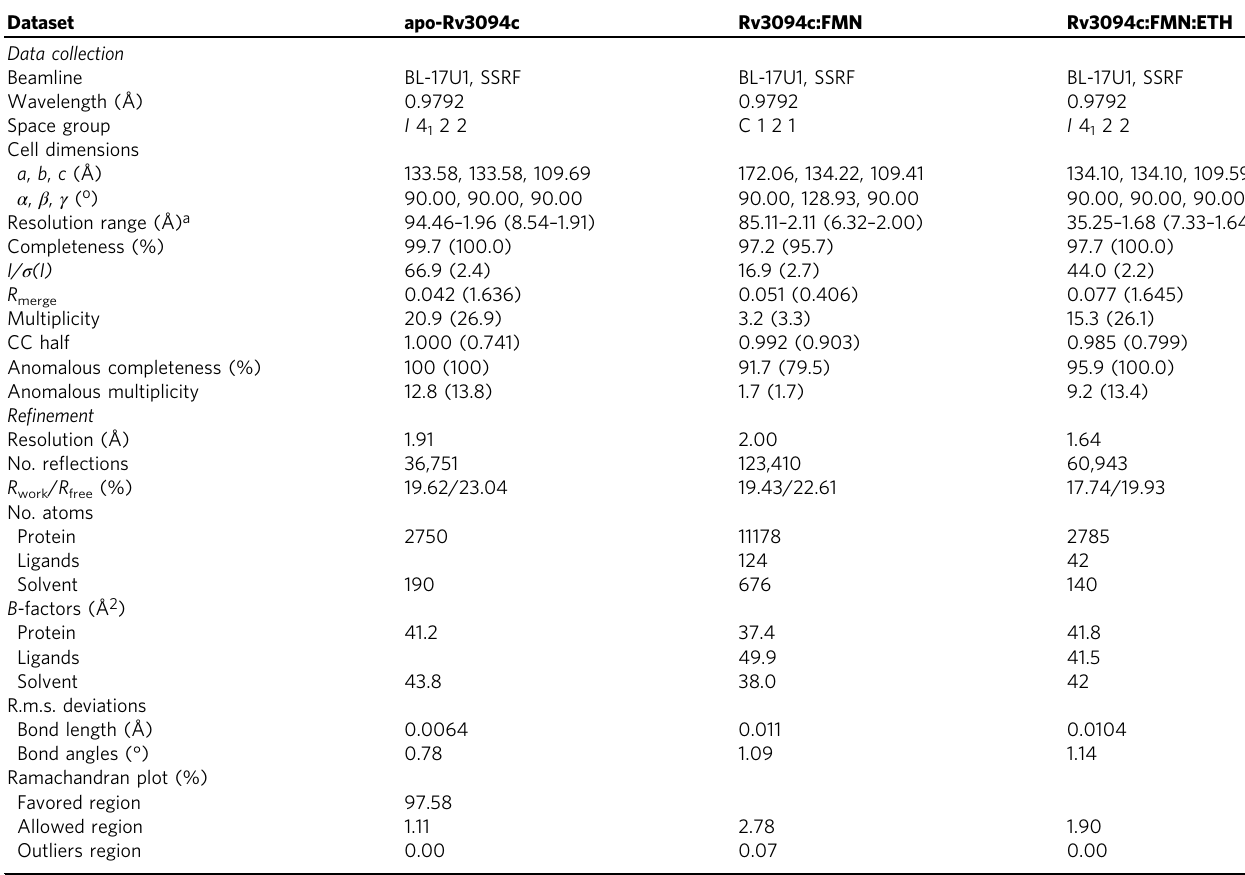
Table 1 X-ray crystallography data collection and re fi nement statistics for